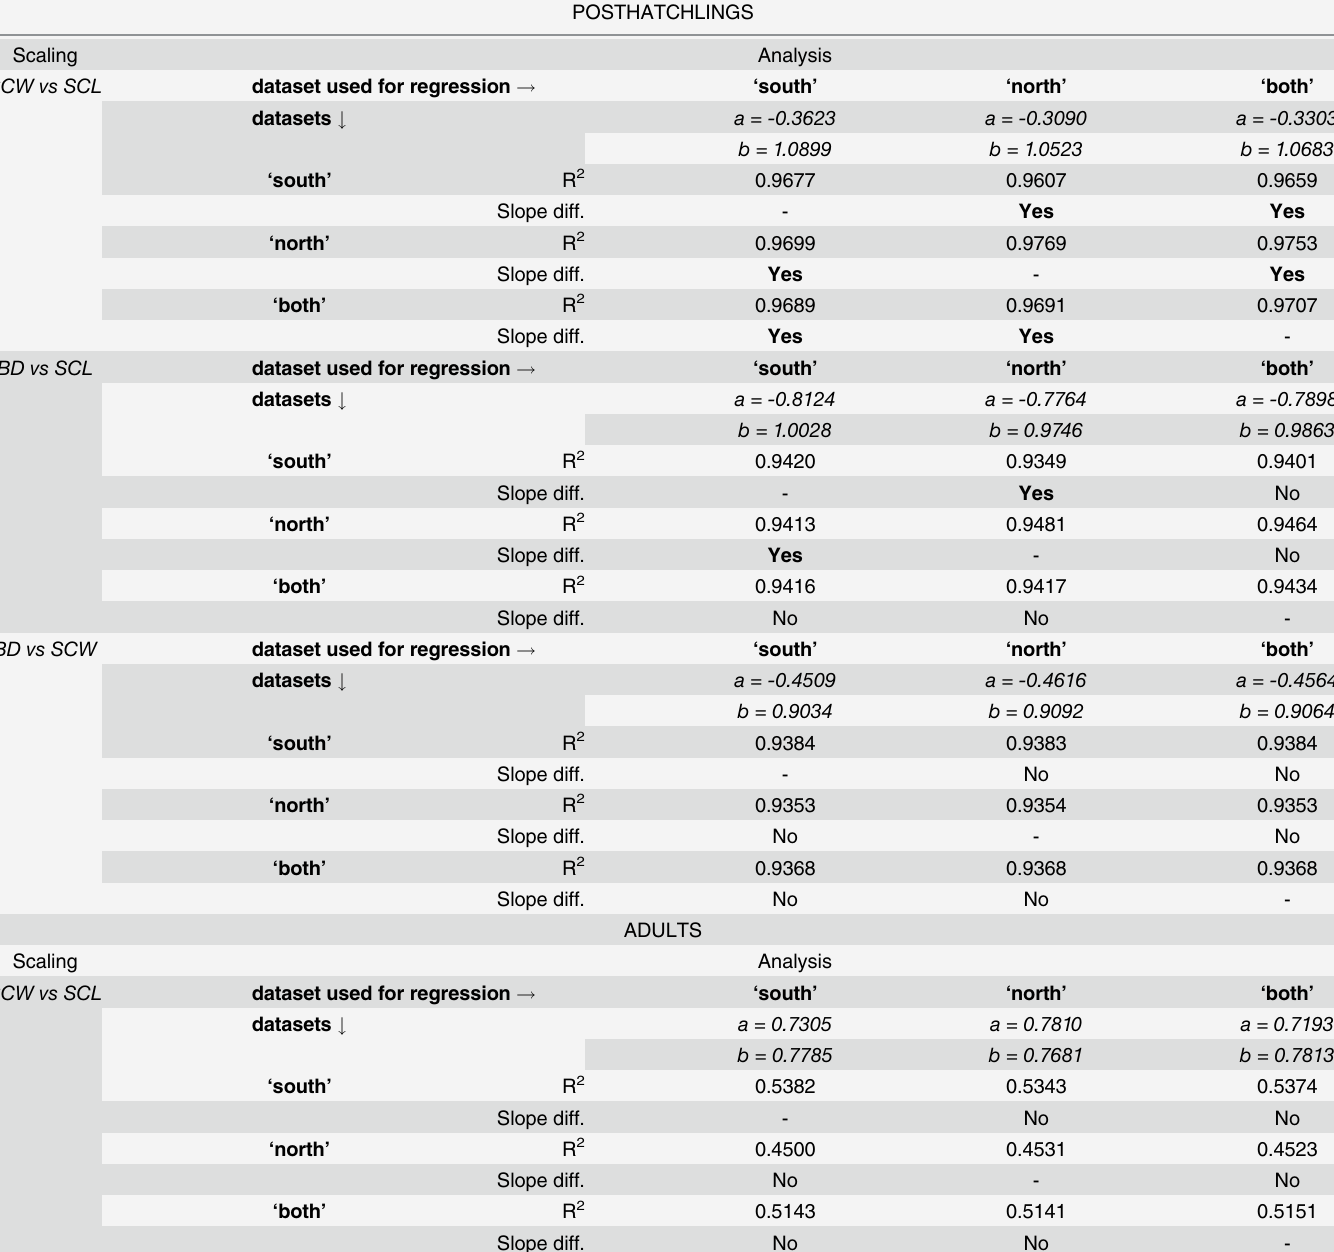
Table 3. Analysis of linear scaling models for regional subsets ‘ north ’ and ‘ south ’ . For each dataset (listed under ‘ datasets ’ ) we analyzed the perfor- mance of three predictive regression equations, differing only in the values of model parameters. Parameter values are given under the name of the dataset used for regression. R 2 value describes the goodness of fit of the regression equation listed in the column to the dataset listed in the row. ‘ Slope diff ’ indicates whether or not the slopes of two regression equations are significantly different (Tukey-Kramer test, p < 0.05), where one regression equation is specific for the dataset listed in the row, and the other for the dataset listed in the column. All regression equations are in the form of y = a + b (cid:2) x (Eqs 1 – 3 in ‘ Methods ’ ). We analyzed separately data from posthatchlings and adults, see subsection Data for